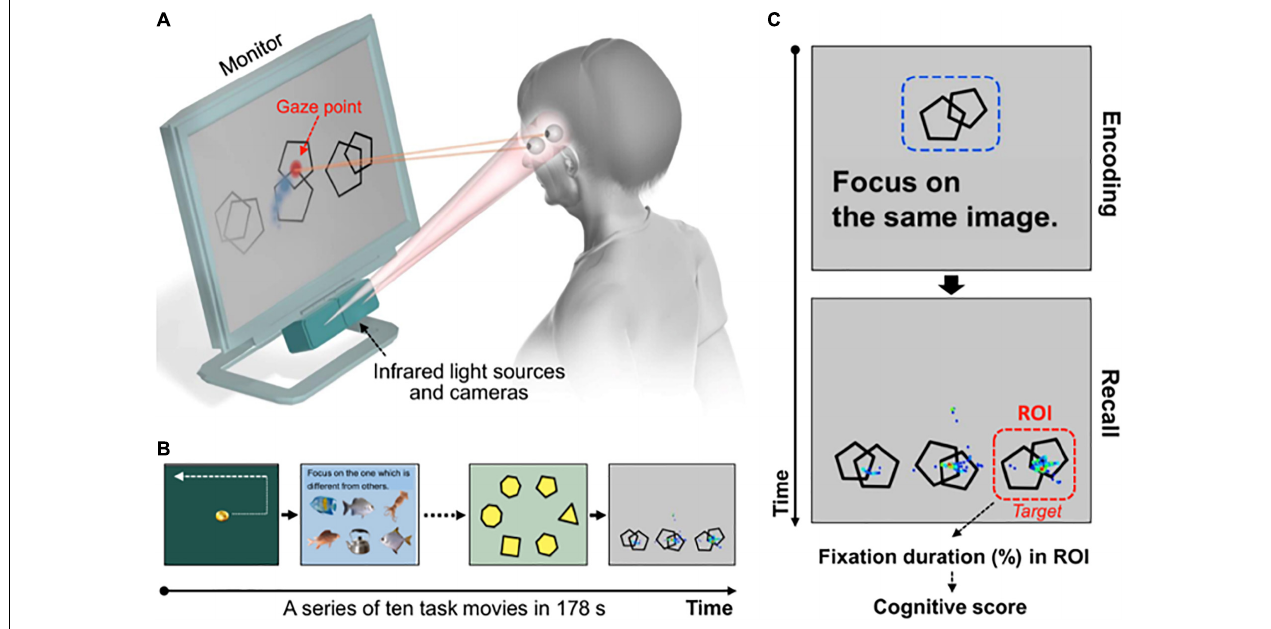
FIGURE 1 | Rapid cognitive assessment using an eye-tracking system and tasks, obtained from Oyama et al. (2019). (A) Participant’s gaze points are recorded. (B) Ten tasks are displayed one by one on the monitor. (C) An example of a working memory task and representative gaze plots with a duration-based heatmap obtained from a control subject. Gaze plots represent the location and time spent looking at the objects. A cue object (e.g., a set of double pentagons) is presented for 10 s ( encoding phase ), followed by three distinct objects with the same one as the cue object (right bottom on the monitor, target ). In the next phase ( recall ) the participant is asked to remember and gaze at the target object. Fixation duration within the region of interest (ROI) set on the target object is used to obtain the cognitive score.